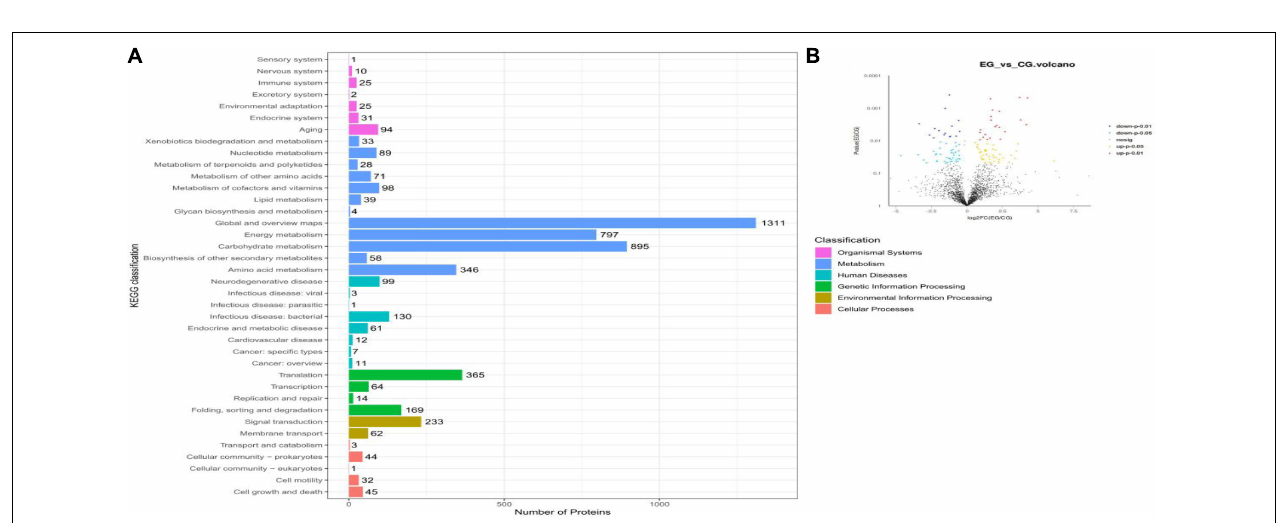
FIGURE 2 | Effect of creatine pyruvate on body temperature (A) , respiratory frequency (B) , rumen fermentation parameter (C–G) , and nutrient digestibility (H) of beef cattle. The rumen fermentation parameter including ruminal pH (C) , the concentration of microbial crude protein [MCP; (D) , NH 3 -N (E) , and total VFA (F) , the proportion of individual VFA (G) . CG, control group; EG, experimental group, diet supplemented with 60 g/day CrPyr. n = 3 per group. * P < 0.05, ** P < 0.01.